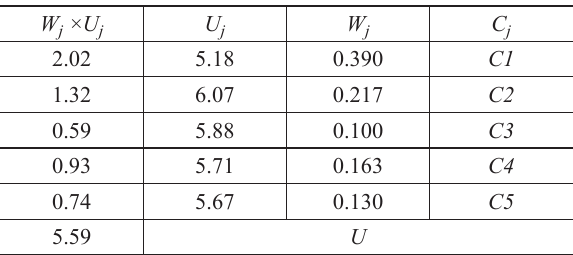
Table 23. Calculation table of overall score